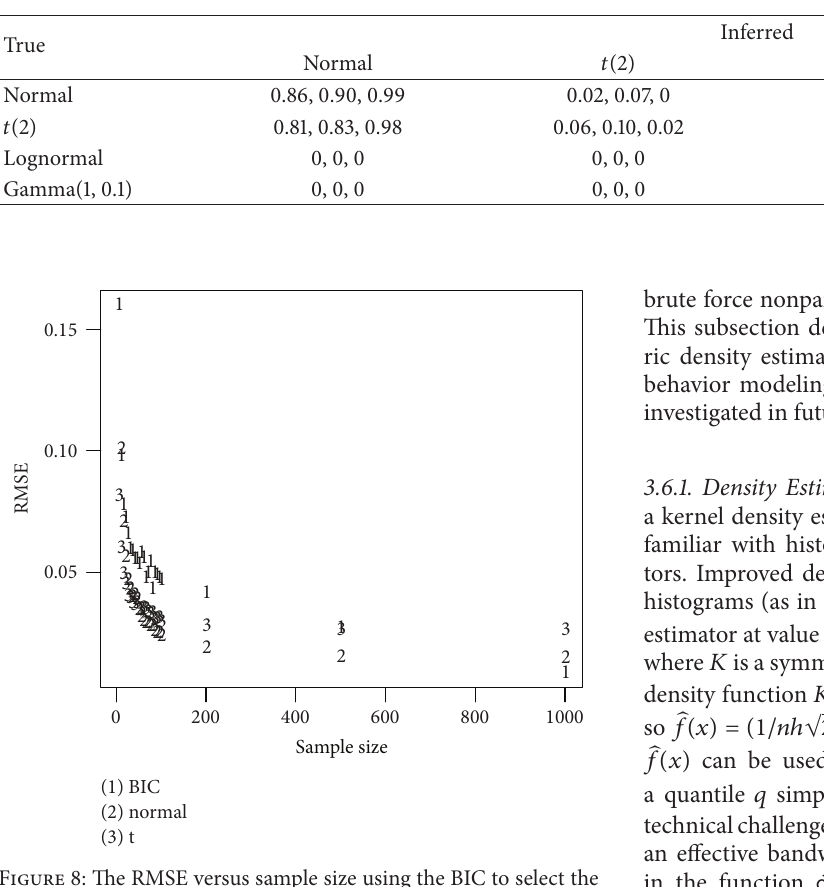
Figure 8: The RMSE versus sample size using the BIC to select the model, or blindly assuming the normal or 𝑡